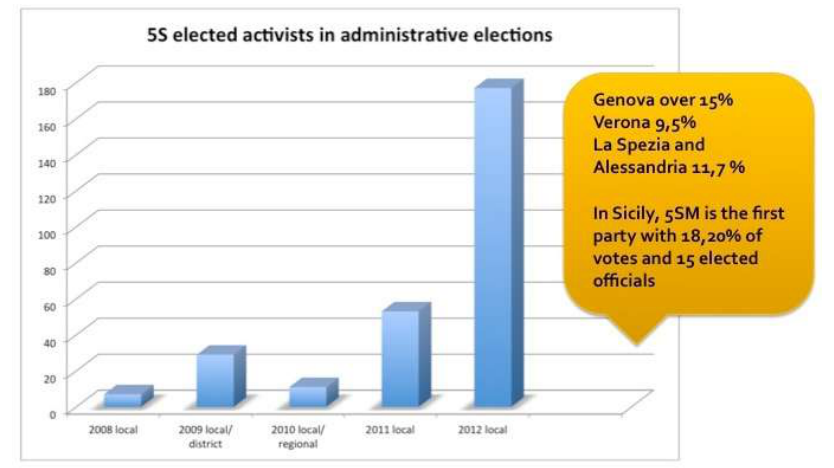
Figure1: Five Star Movement Local Election Results During the local elections of June 2009, civil lists stood for election in 64 local administrations (town council) through the work of their local MeetUp groups. 23 of their candidates were elected as borough officials and 6 as district representatives. In Bologna the 5SM activists represented 10% of the elected leadership. During the local elections of 2012, the Movement stood for election in 101 local administrations and were successful almost everywhere: in Genova (over 15%), Verona (9.5%) La Spezia and Alessandria (11.7%). In the Regional elections in Sicily the same year, they were the first party with the most votes, gaining 18.20% of the votes and with 15 elected Regional Representatives. As far as the General elections in 2013 are concerned, the SWG polls put them in third place. Much of this success is attributed to Gianroberto Casaleggio, an expert in social network marketing, whose staff organises the MeetUp networks, defines the rules, evaluates candidates and handles local